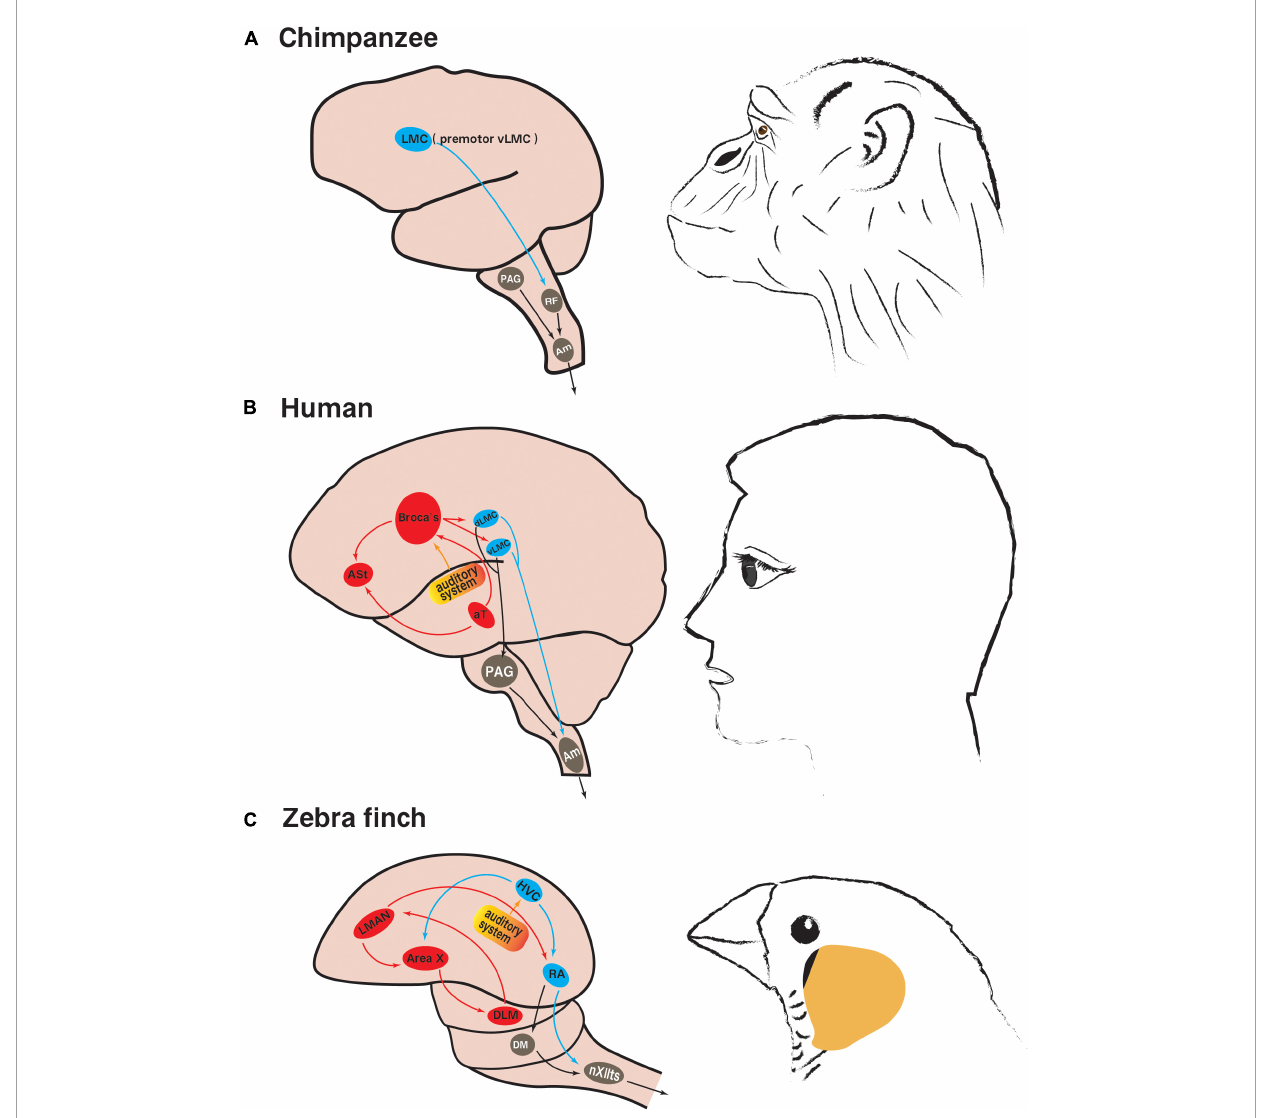
FIGURE2 Neural pathways involved in innate vocalization and vocal learning. (A) Vocalization-related pathways in non-human primate chimpanzees (based on Kaas, 2012; Simonyan, 2014): the limbic vocal control pathway in gray; the laryngeal motor cortex pathway in blue. (B) Vocalization-related pathways in humans (based on Jarvis, 2007; Simonyan, 2014; Neef et al., 2021): the limbic vocal control pathway in gray; the laryngeal motor cortical pathway in blue; the language learning pathway in red. (C) Vocalization-related pathways in songbird zebra finches (based on Nottebohm, 1991; Jarvis, 2004): the innate brainstem vocal pathway in gray; the vocal motor pathway in blue; the anterior forebrain pathway related to song learning in red. The brain regions of the same color in songbirds and humans are analogous. The yellow part is the auditory system. LMC, laryngeal motor cortex; dLMC, dorsal LMC; vLMC, ventral LMC; RF, reticular formation; PAG, periaqueductal gray; Am, nucleus ambiguus; ASt, anterior striatum; aT, anterior thalamus speech area; HVC, used as a proper name; RA, robust nucleus of the arcopallium; LMAN, lateral part of the magnocellular nucleus of the anterior neostriatum; DLM, medial portion of the dorsolateral nucleus of the anterior thalamus; DM, dorsal medial midbrain nucleus; nXIIts, tracheosyringeal part of hypoglossal